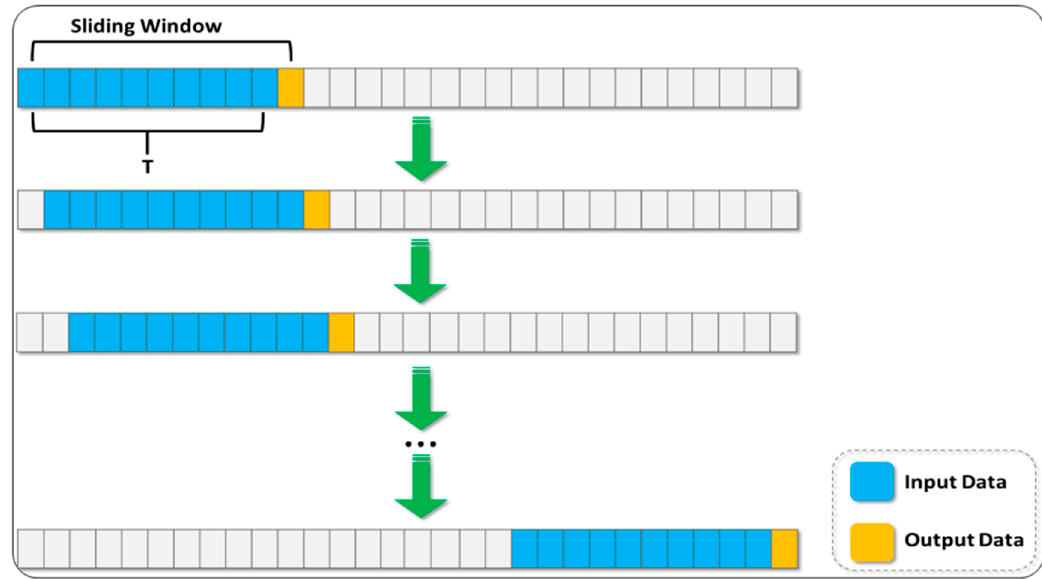
Figure 5. Steps of slide window.